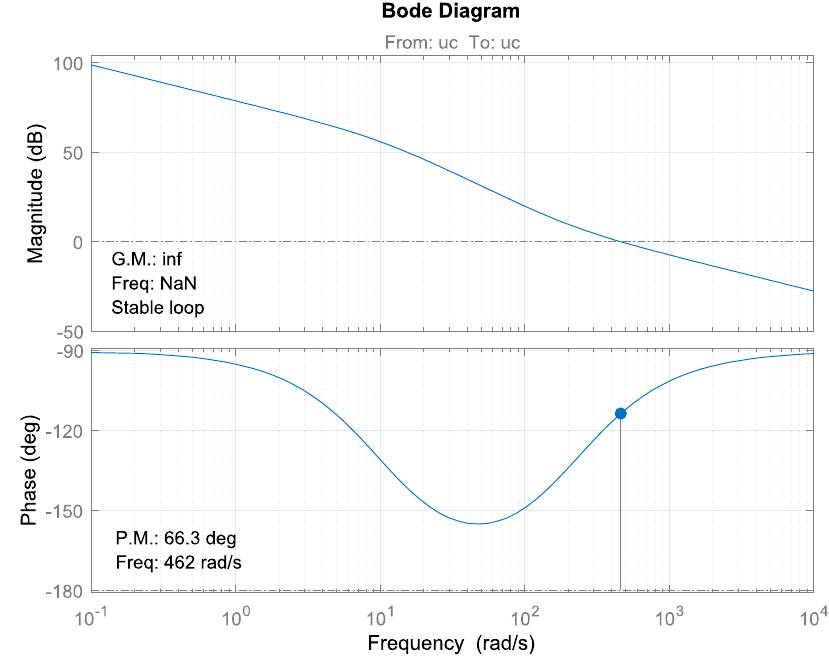
Figure 20. Current control loop Bode diagram.